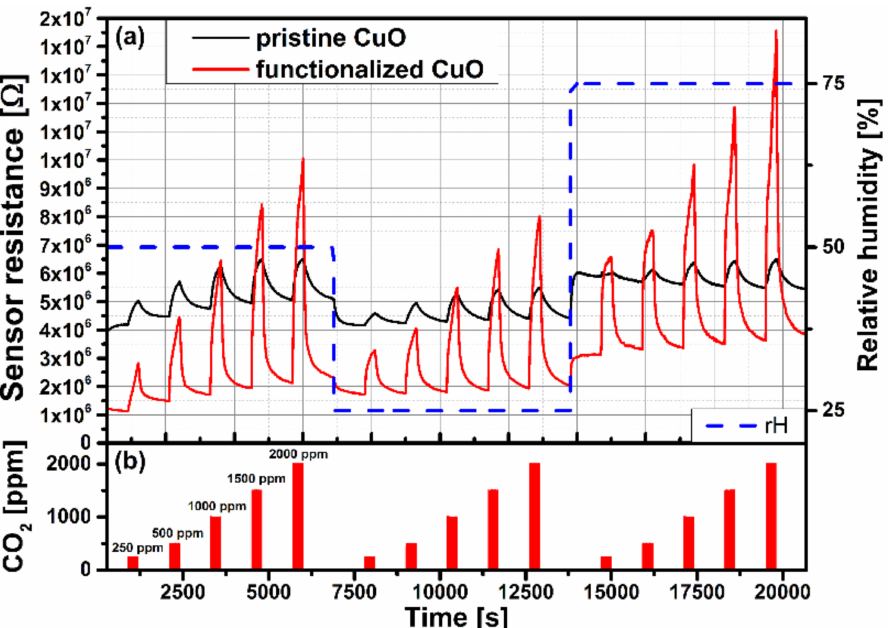
Figure 22. ( a ) Carbon dioxide measurement of pristine and Au-functionalized CuO gas sensors at an operation temperature of 300 ◦ C and relative humidity levels of 25%, 50%, and 75%. ( b ) CO 2 gas pulses: 250 ppm, 500 ppm, 100 ppm, 1500 ppm, and 2000 ppm. Reprinted with permission from